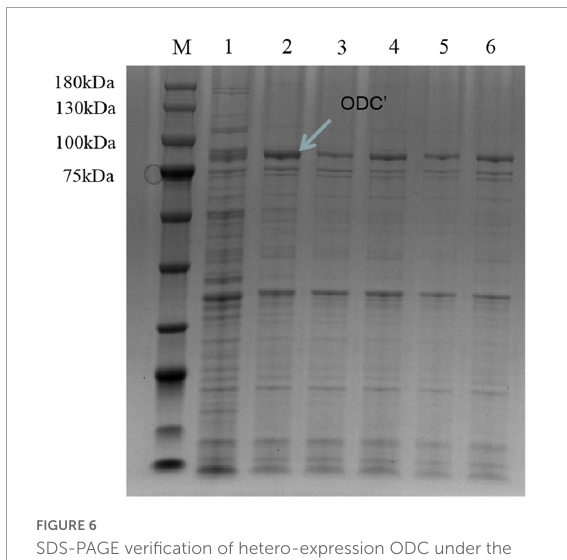
FIGURE6 SDS-PAGE verification of hetero-expression ODC under the inducement condition at 20 ◦ C for 14 h. M represented the protein marker (180 kDa). Line 1 represented hetero-expression ODC with no inducement. Lines 2–6 represented the hetero-expression ODC induced with 0.05, 0.1, 0.3, 0.5, and 0.7 mM IPTG, respectively.